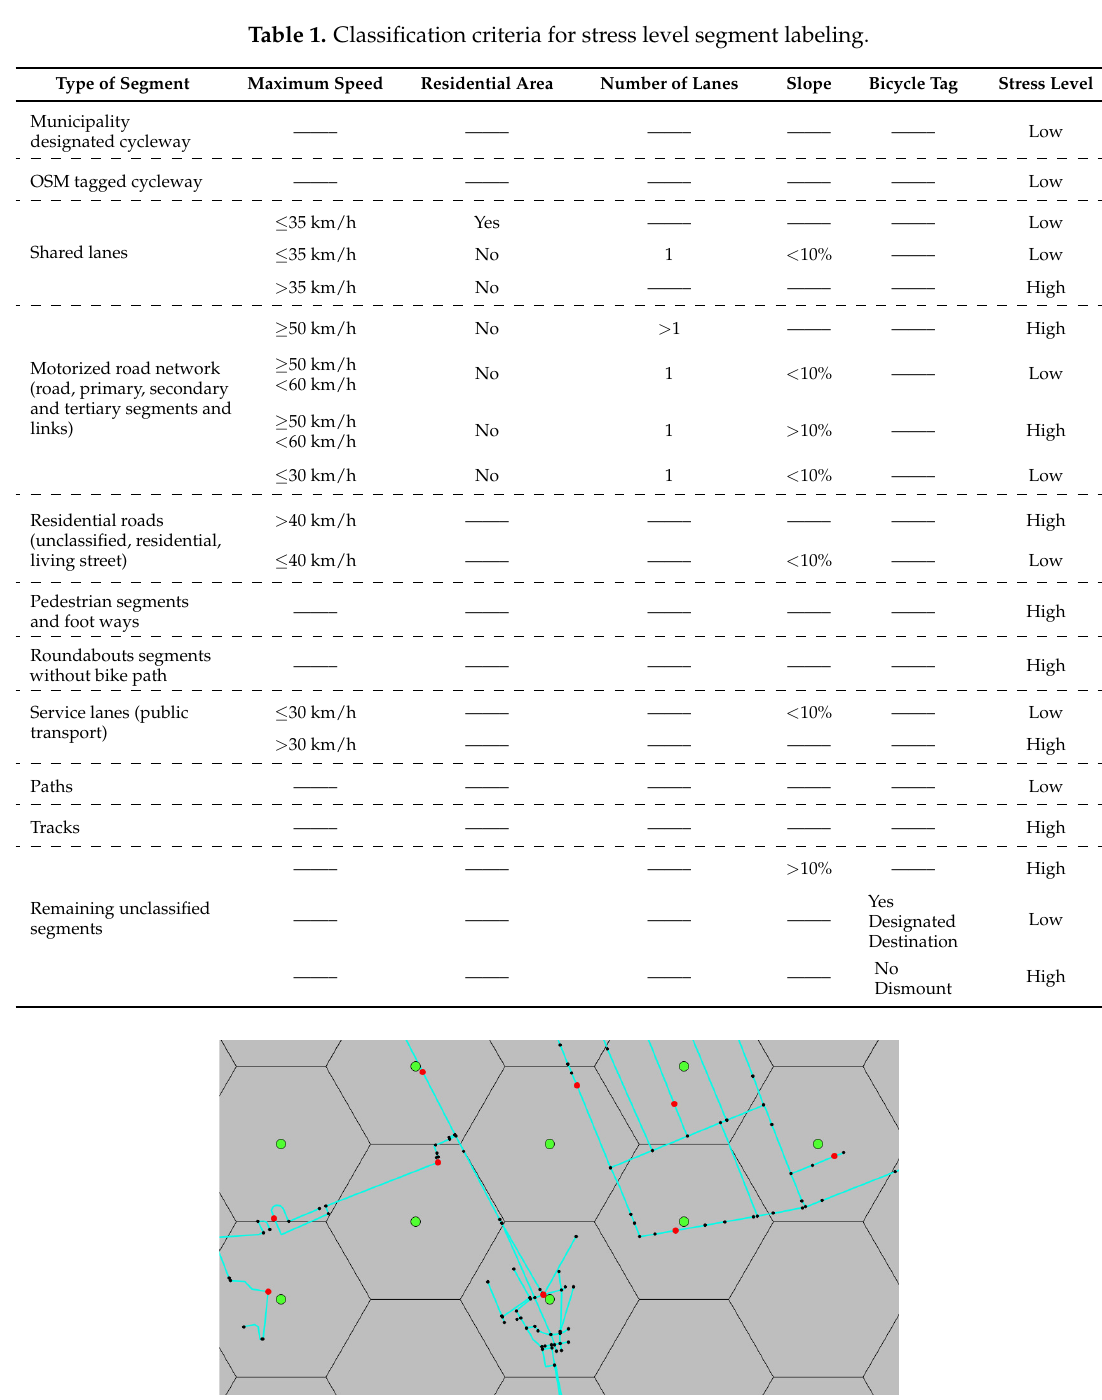
Figure 2. Nearest node selection. The low-stress network consists of the blue lines (edges) and black dots (nodes). The green dots represent the cell centroids. The nearest nodes to each of the cell centroids are colored